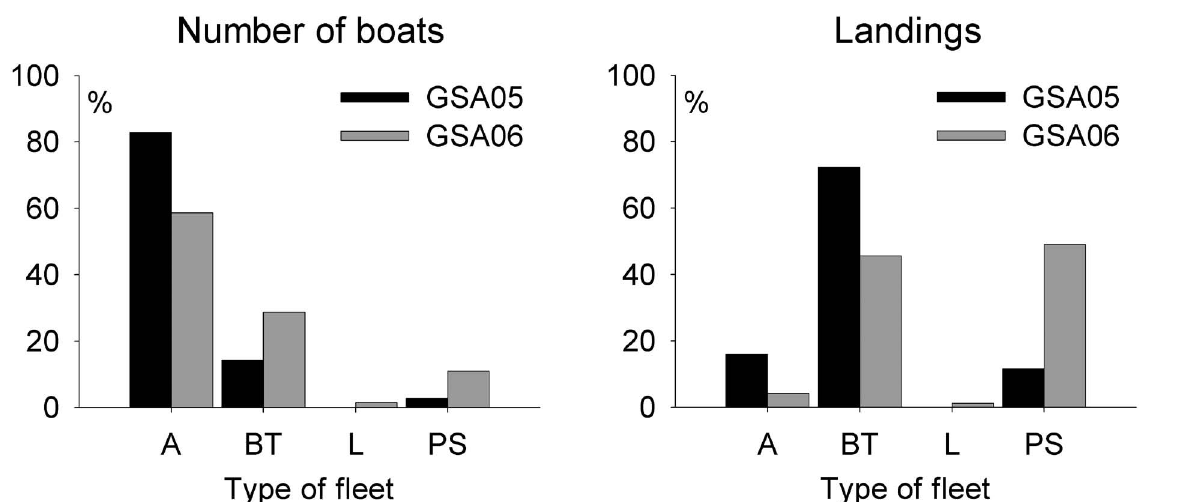
Fig . 2. – Percentage of number of boats (left) and landings in biomass (right) by type of fleet (A: artisanal; BT: bottom trawl; L: long-line; PS: purse-seine) in the geographical sub-areas Balearic Islands (GSA05) and Northern Spain